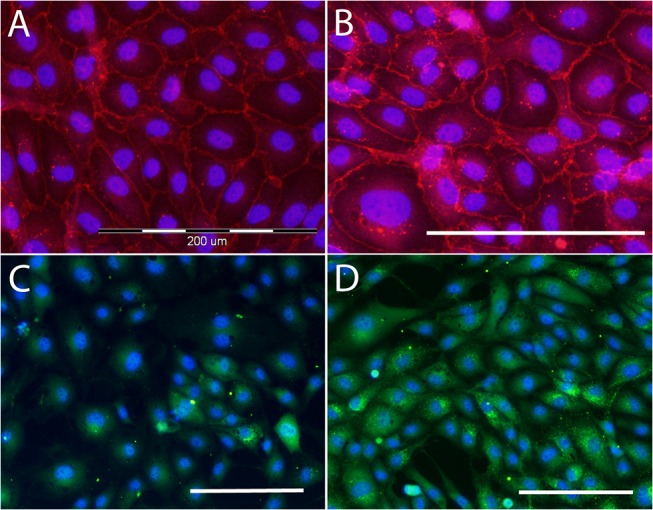
Immunofluorescence staining of VE-cadherin (A,B) and von Willebrand factor (C,D) in CPAE.Cells cultivated on (Alb/Hep)2 (A,C) and on (Alb/Hep)2 with the adsorbed FGF-2ads (30 ng/cm2; (Alb/Hep)2FGF-2adsLow; B,D). The cells are counterstained with Hoechst 33342. Obj. ×20 (A,B), obj. ×10 (C,D), scale bar = 200 μm.